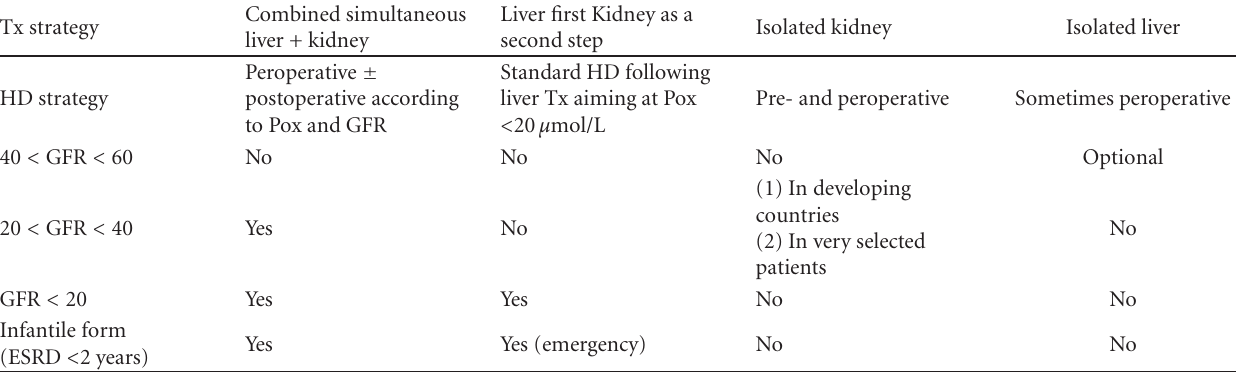
Table 2: Suggestions for organ transplantation strategies in PH1 patients according to residual GFR (ml/minper 1.73m 2 ), systemic involvement, and local facilities (from